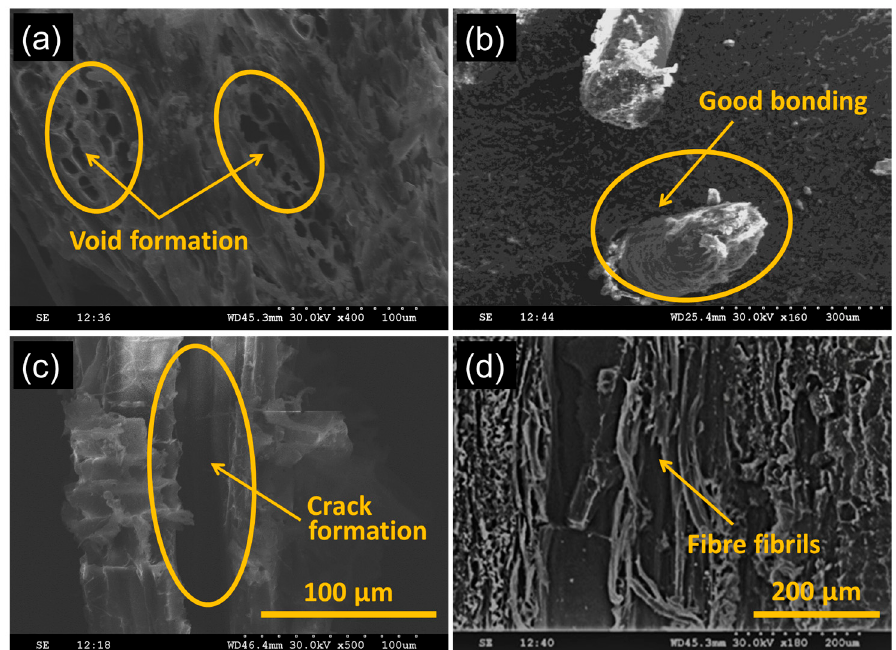
Figure 3. SEM images of composite that underwent cryogenic treatment for duration of ( a ) 30 min,